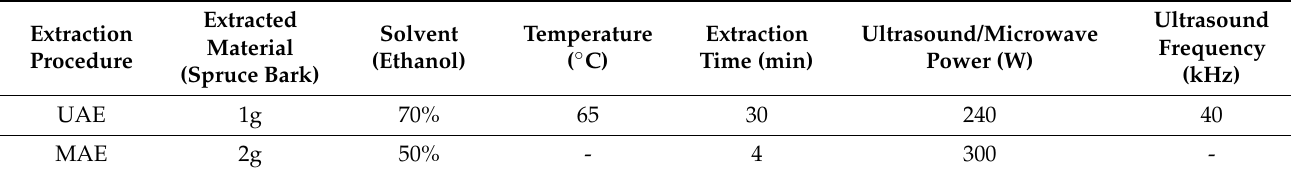
Table 4. Extraction parameters.